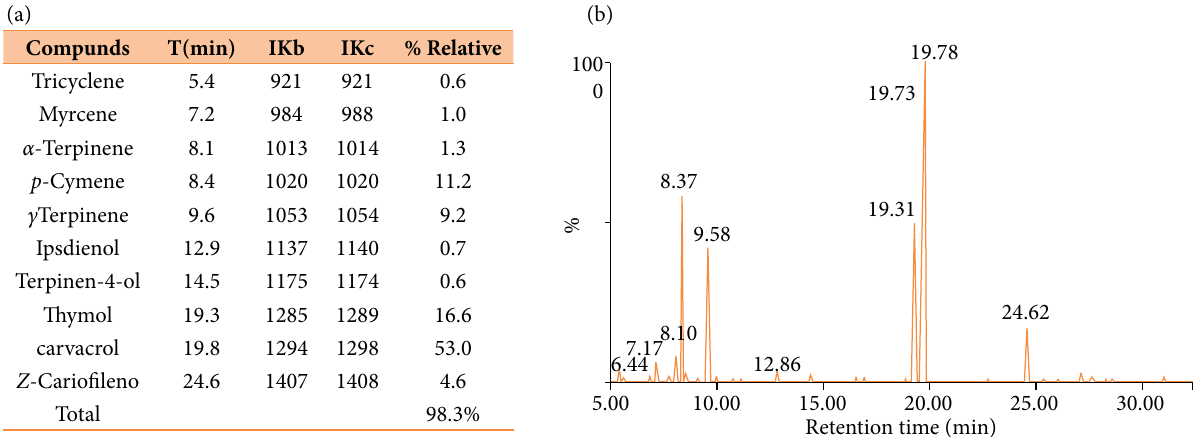
Figure 1 - (a) Chemical composition of the essential oil obtained from L. gracilis Schauer leaves. Compounds are listed in order of election in a nonpolar DB-5 column; retention indices calculated through the retention times in relation to the n-alkanes series (C9-C19) in a Phenomenex ZB5-MS 30 m × 0.25 μ column; % Relative: relative percentage of the